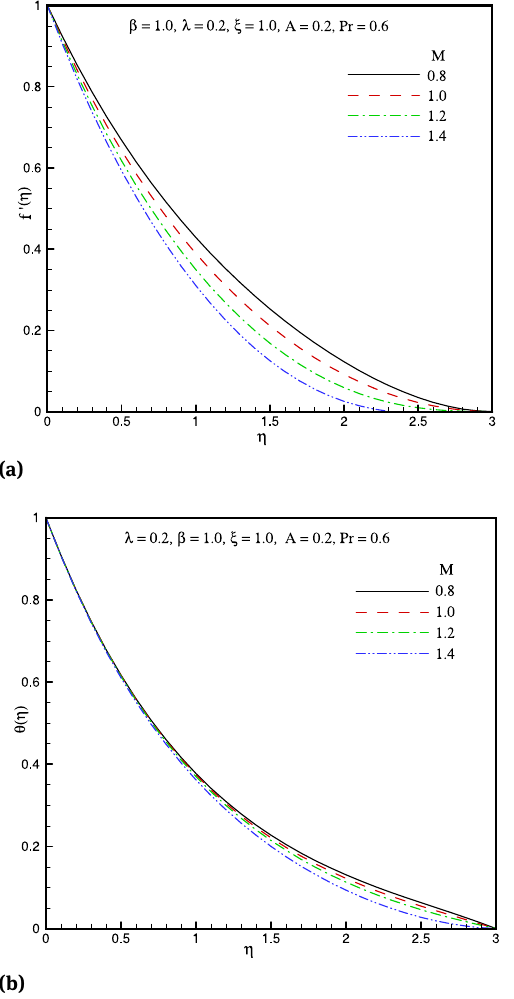
Figure 7: Simulated velocity and temperature profiles for various values of magnetic